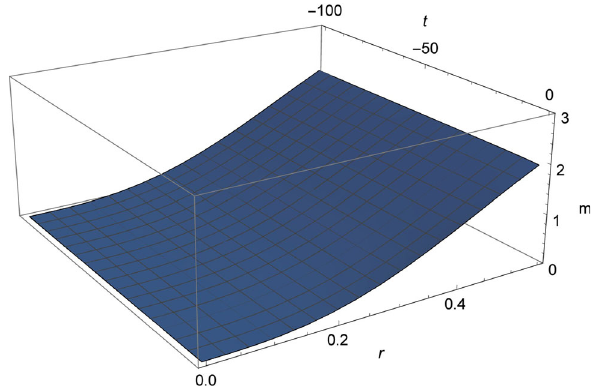
Fig. 5 Total mass, c 1 = 0 . 81, c 2 = 0 . 5, c 3 = − 10, c 4 = − 10, ζ = − 0 . 2, R = 6 . 62, r = 0 . 55 and (cid:7) = 0 . 1 0